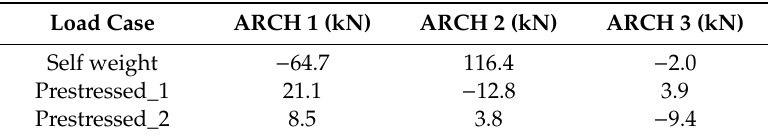
Table 14. Forces in di ff erent load cases.